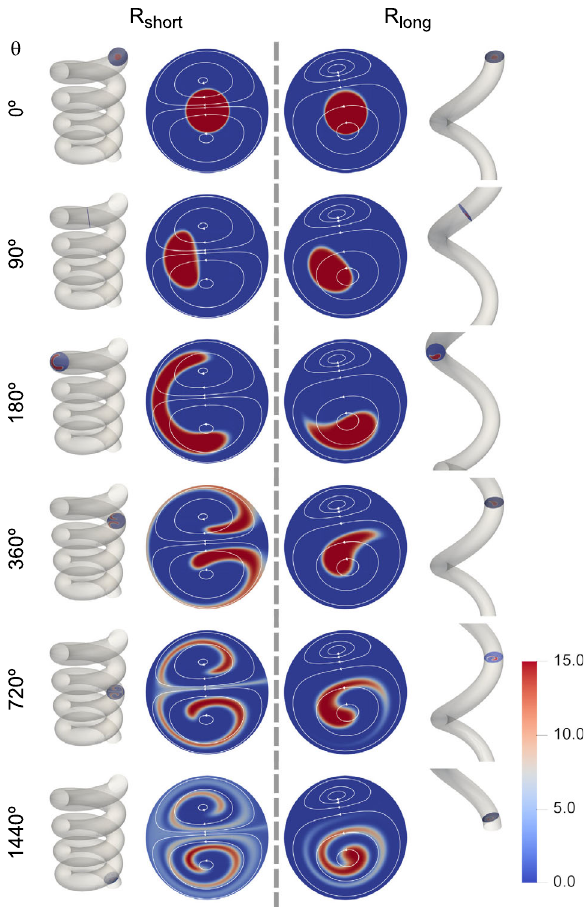
Fig. 2 Mass transport in short- and long-pitch devices. Concentration distribution of TPPS 3 at selected cross-sections along the entire length of the helical channel (four turns) for R short and R long devices (left and right, respectively). The fi rst picture at θ = 0 corresponds to the inlet region and shows the concentric 3D focussing. Snapshots taken from Supplementary Movie 1. The concentration distribution of TPPS 3 evolves in a markedly different way in the two devices, with the porphyrin remaining exposed exclusively to the CCW vortex in R long and to both the CCW and the CW vortices in R short .